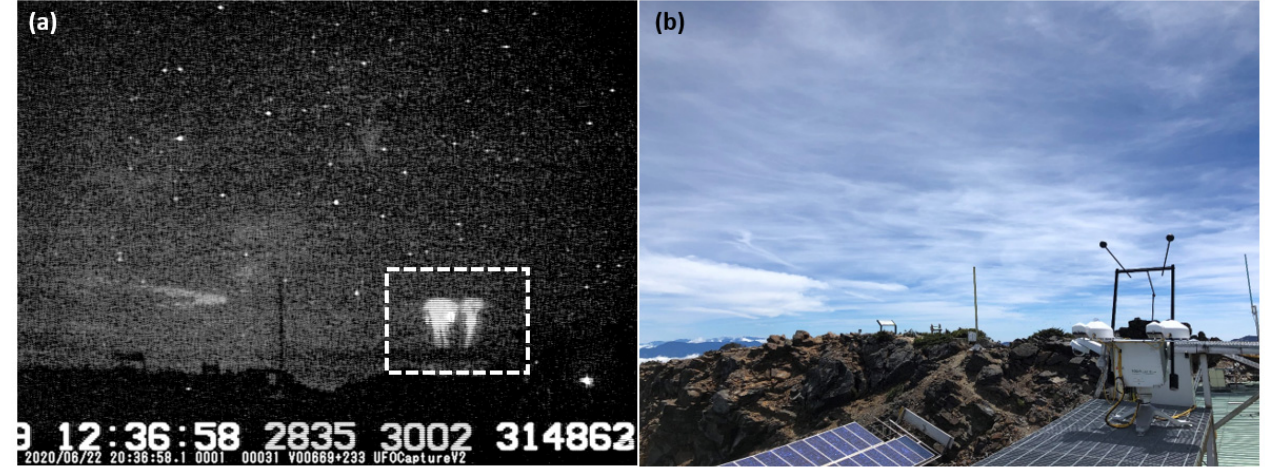
Figure 3. ( a ) The sprite event recorded by the low-light-level CCD at nighttime, where the rectangle indicates the two carrot sprites, and ( b ) the corresponding view of geometry at daytime.